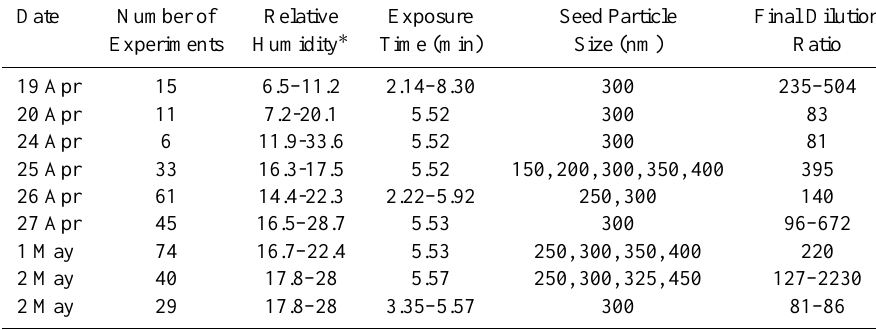
Table 2. Uptake and condensation control parameter range during the